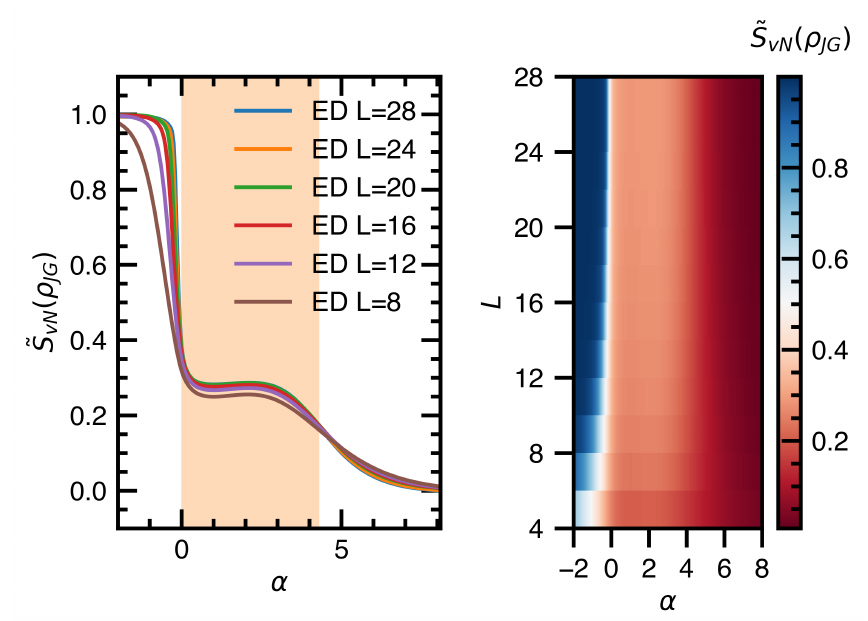
( ρ ) is plotted versus the parameter α for different Figure 3: (Left) The function ˜ S JG vN L . Here ρ is the half-system reduced density matrix of the JG state. The shaded JG area corresponds to states in the critical regime. (Right) Entanglement entropy of the JG reduced density matrix. The critical region extends for α ∈ ( 0,4.30 )